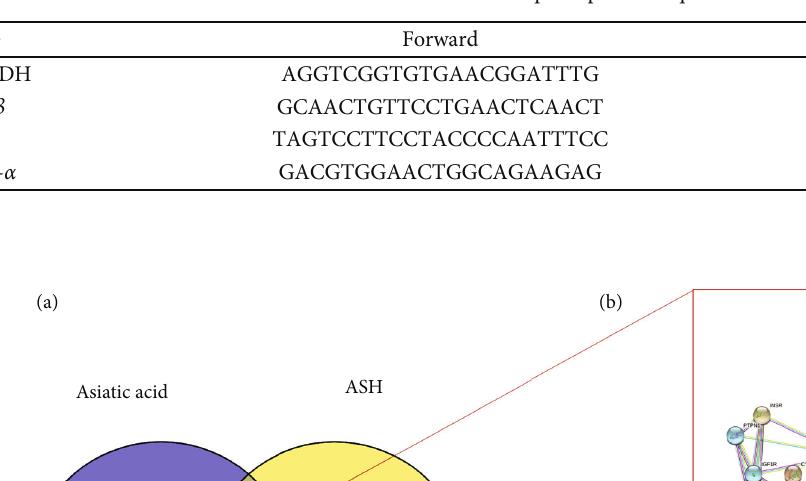
Table 1: RT-qPCR primer